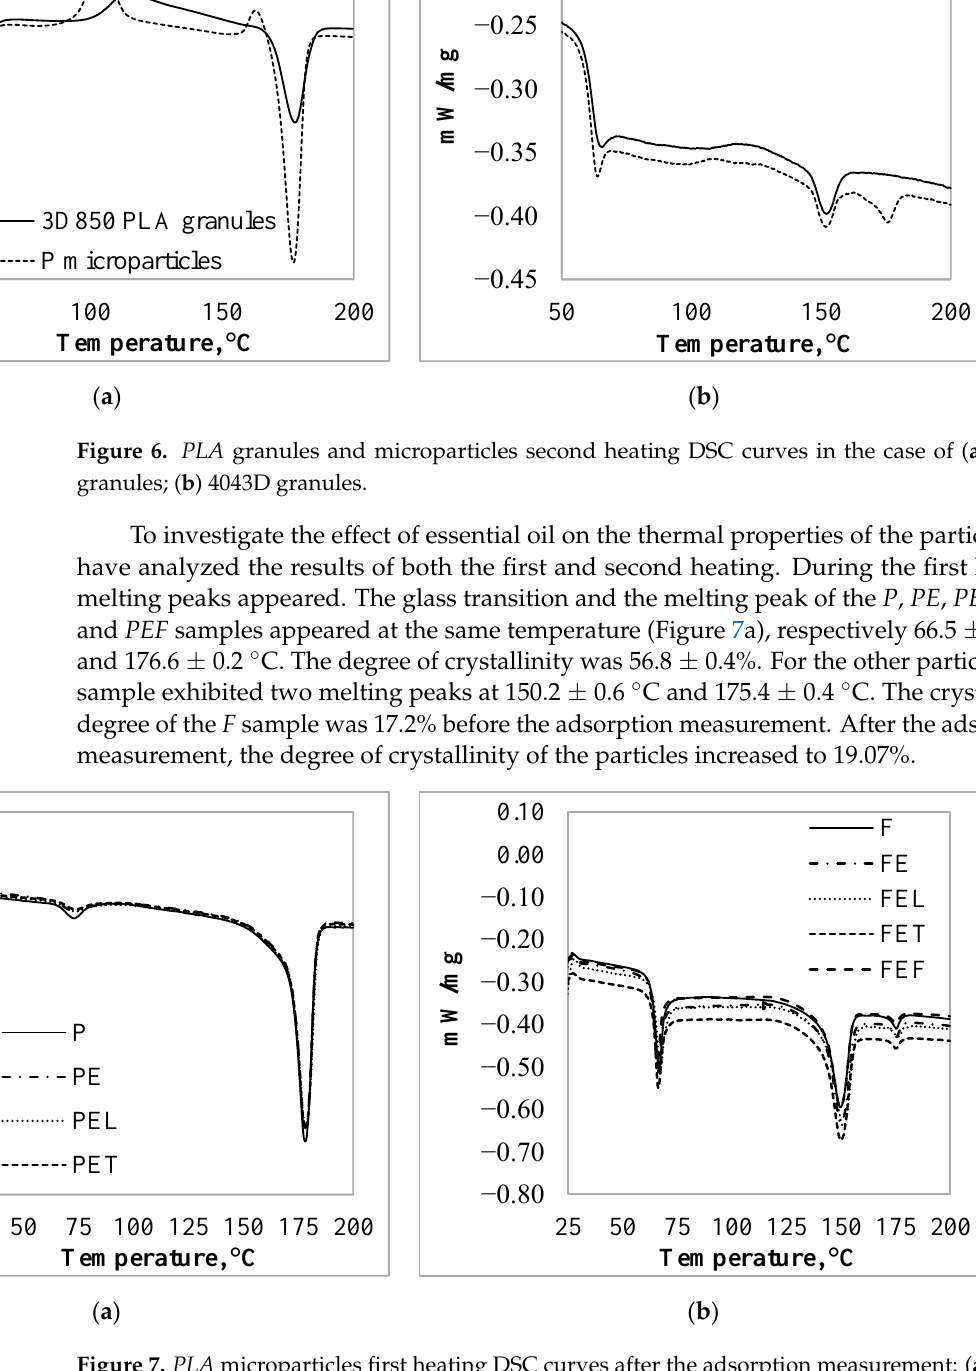
( b ) Figure 8. PLA microparticles second heating DSC curves after the adsorption measurement: ( a ) 3D850 granules; ( b ) 4043D granules. Based on the results of the first and second heating, we concluded that after the ad- sorption measurement the thermal characteristic of the P microparticle did not change under the influence of the solvent or the essential oil solutions. However, the results of the first heating step for the F particles showed that the adsorption of essential oils had little effect on the properties of the PLA , as the degree of crystallinity of the particles in- creased by 2%.